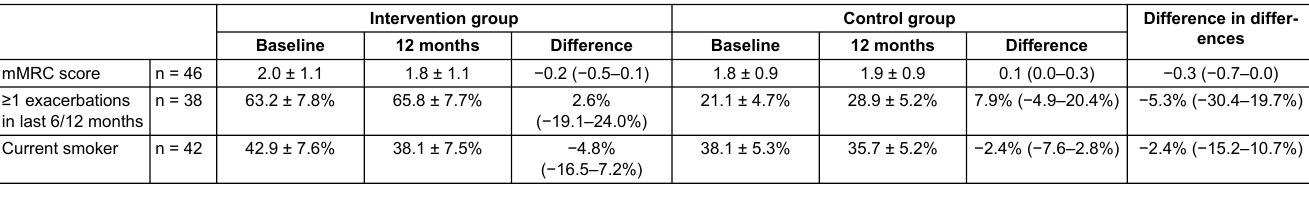
Table 4: mMRC score, number of exacerbations and proportion of current smoker: within and between group differences at 12